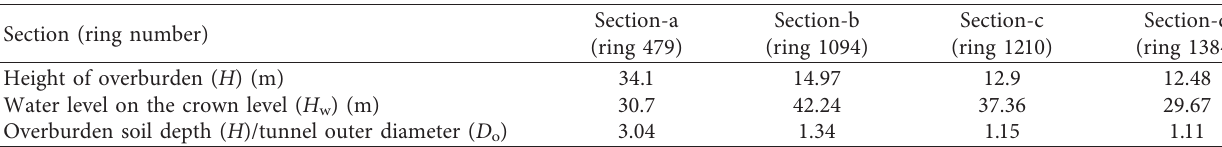
Table 2: Basic parameters of the monitored sections of the